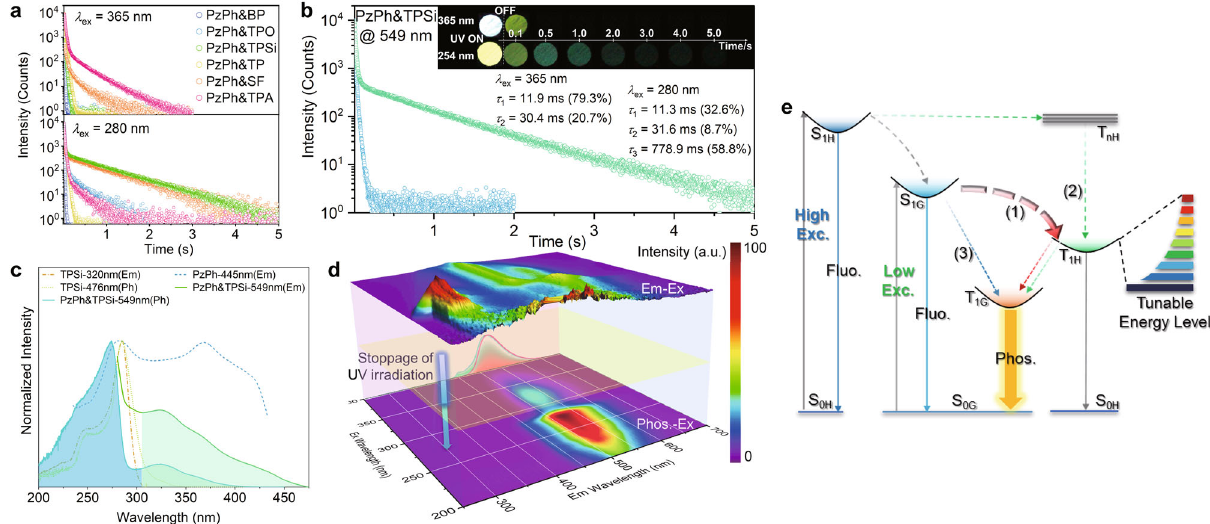
Fig. 3 Excitation-dependent UOP properties and UOP mechanism of the mH/G UOP system. a Time-resolved decay curves for the mH/G UOP system under 365 nm and 280 nm excitation. b Time-resolved decay curves of PzPh&TPSi under 365 nm and 280 nm excitation (inset: Photographs taken under a 365 or 254 nm UV lamp on and off). c Excitation spectra of PzPh, TPSi, and their doping system ( “ Em ” was referred to the steady-state emission peak, and “ Ph ” was referred to the phosphorescence emission peak). d Excitation-emission mapping of PzPh&TPSi under ambient conditions (top: excitation-steady- state emission mapping; bottom: excitation-delayed emission mapping, the Rayleigh scattering was removed by Delaunay triangulation method 44 – 46 ; side: phosphorescence spectra taken under 365 nm (red line) and 280 nm (green line) excitation). e Jablonski diagram for proposed photophysical processes between host and guest species in the mH/G UOP